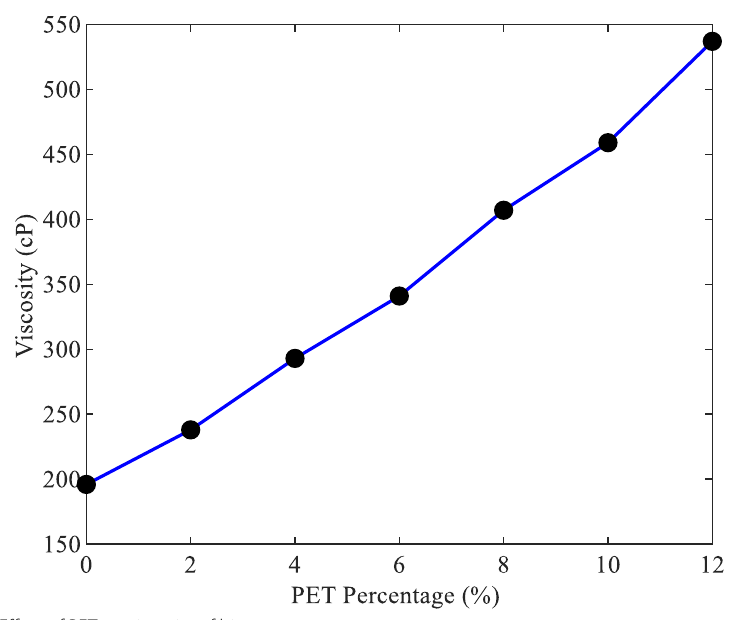
Fig.18 Effect of PET on viscosity of bitumen